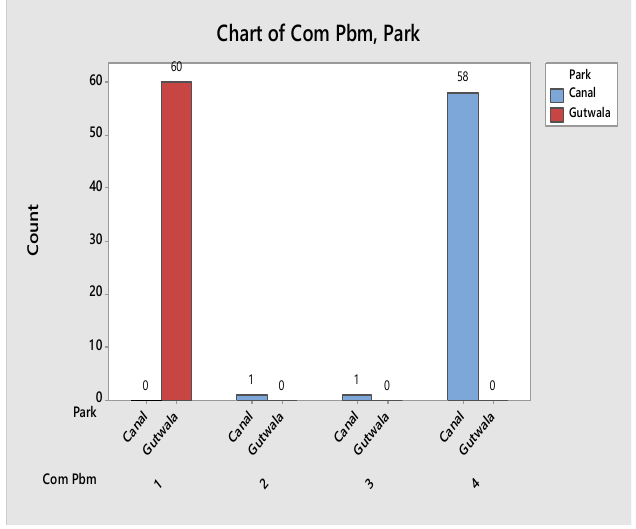
Figure 13: Bar Chart of Sleep Loss problem between both sites Graphical representation of the visitors affected by the noise levels in both sites for sleep loss showed that 6 out of 60 visitors responded highly affected by the sleep loss due to noise pollution and 8 out 60 showed mild and 46 out of 60 showed low response in the site-1 Canal Park, contrarily, all sampled 60 visitors in the Site-2 Gat Wala Park did not show any symptom of sleep loss due to noise pollution, It was observed during the instant qualitative results that Gat Wala Park is peaceful and calm while environment of the Canal Park is noisy and affecting health of the